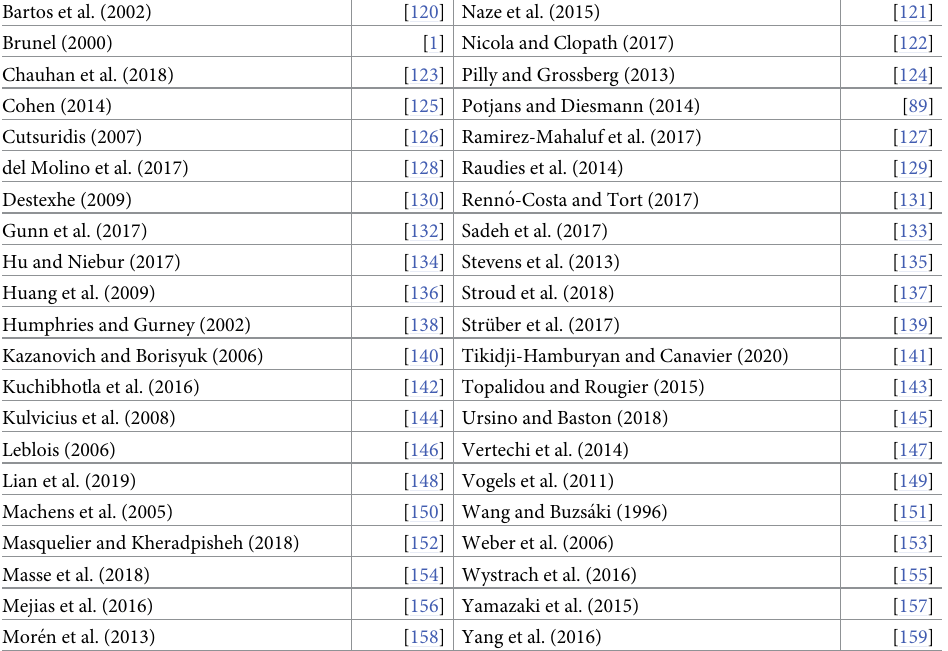
Table 2. Alphabetical list of articles describing the reviewed network models. Bartos et al.